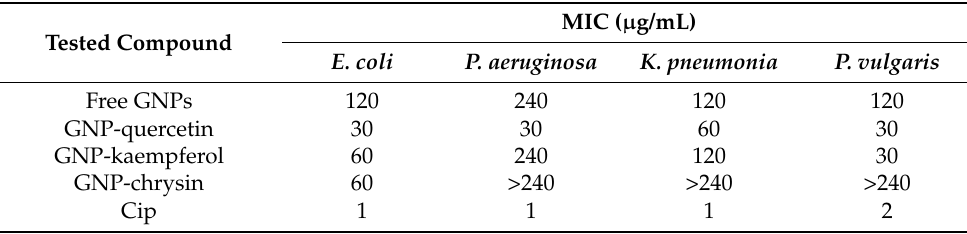
Table 1. Antibacterial activity of the gold nano-conjugates against Gram-negative bacteria.